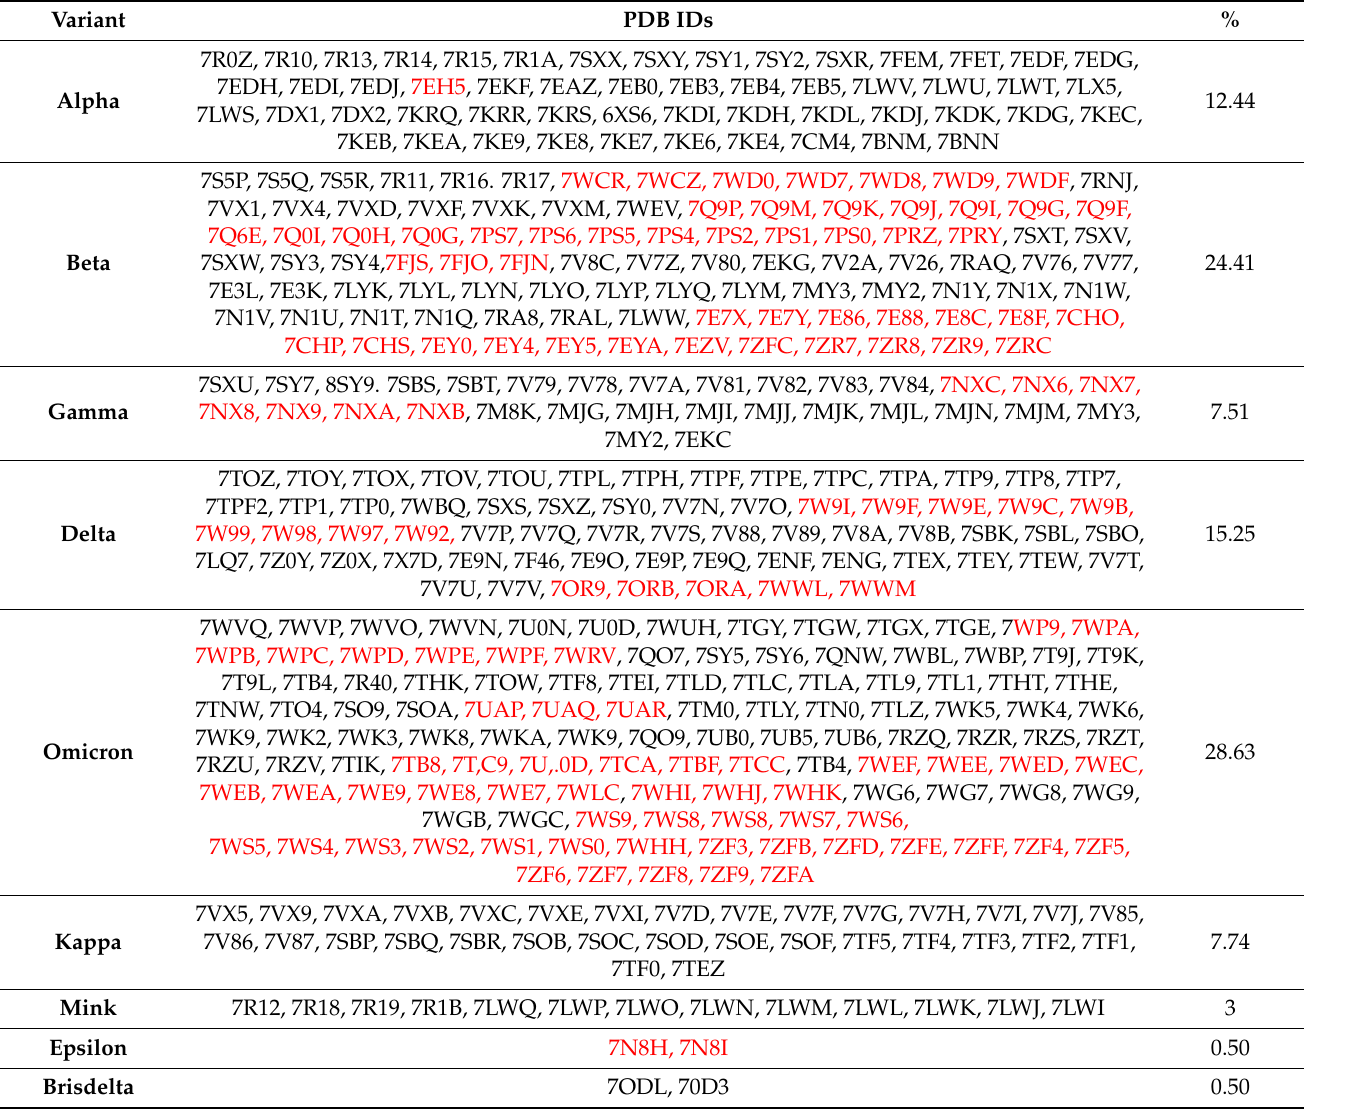
Table 4. PDB IDs for SARS-CoV-2 variants. Red-colored PIDs represent those structures that are used in complex with